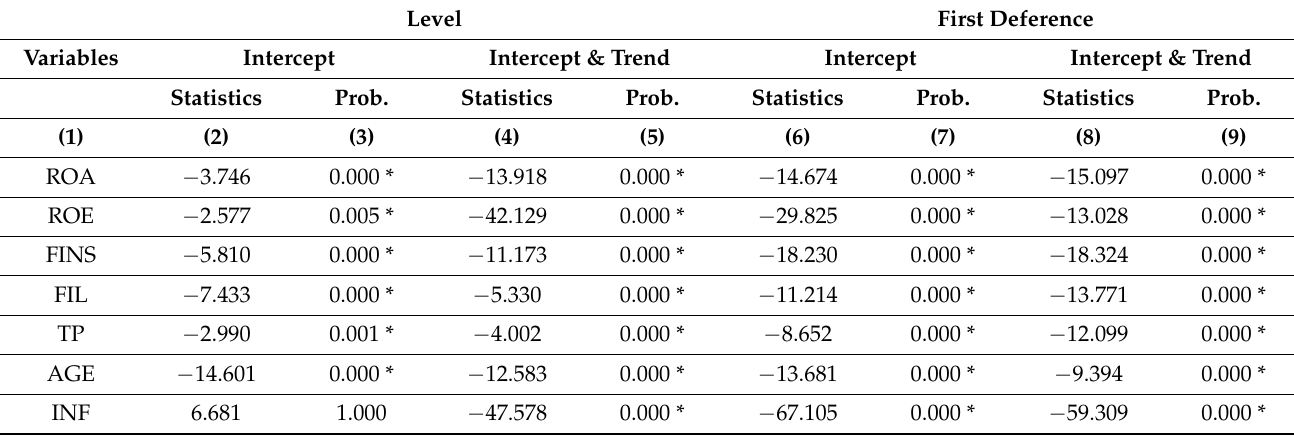
Table 7. The results of LLC Unit Root